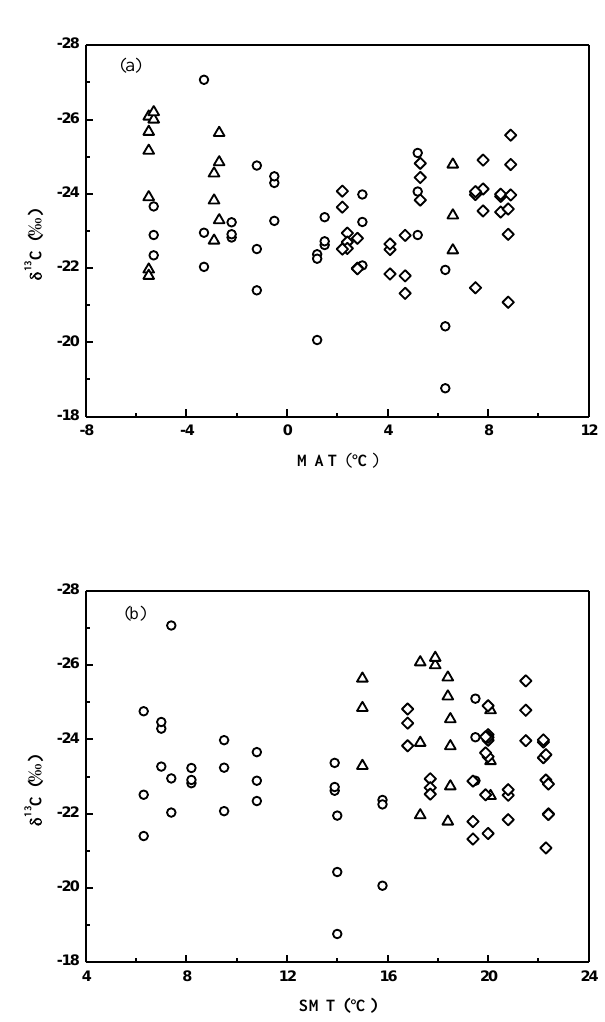
Figure 2. Shows the variance in surface soil δ 13 C with MAT (a) and SMT (b) along the 400mm isoline in China. Circle represents alpine and subalpine; diamond indicates temperate steppe and grassland; triangle is coniferous